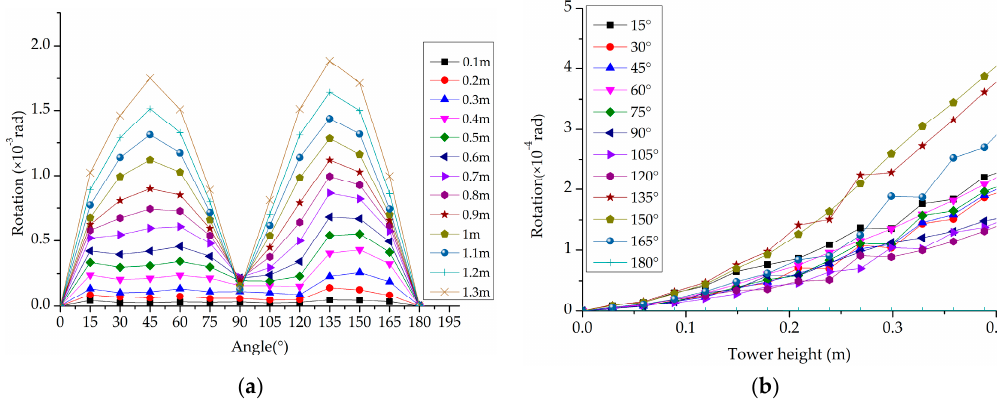
Figure 6. Rotation of the tower model under various direction angles on Line 1. ( a ) Rotation versus direction angle, ( b ) rotation versus tower height.